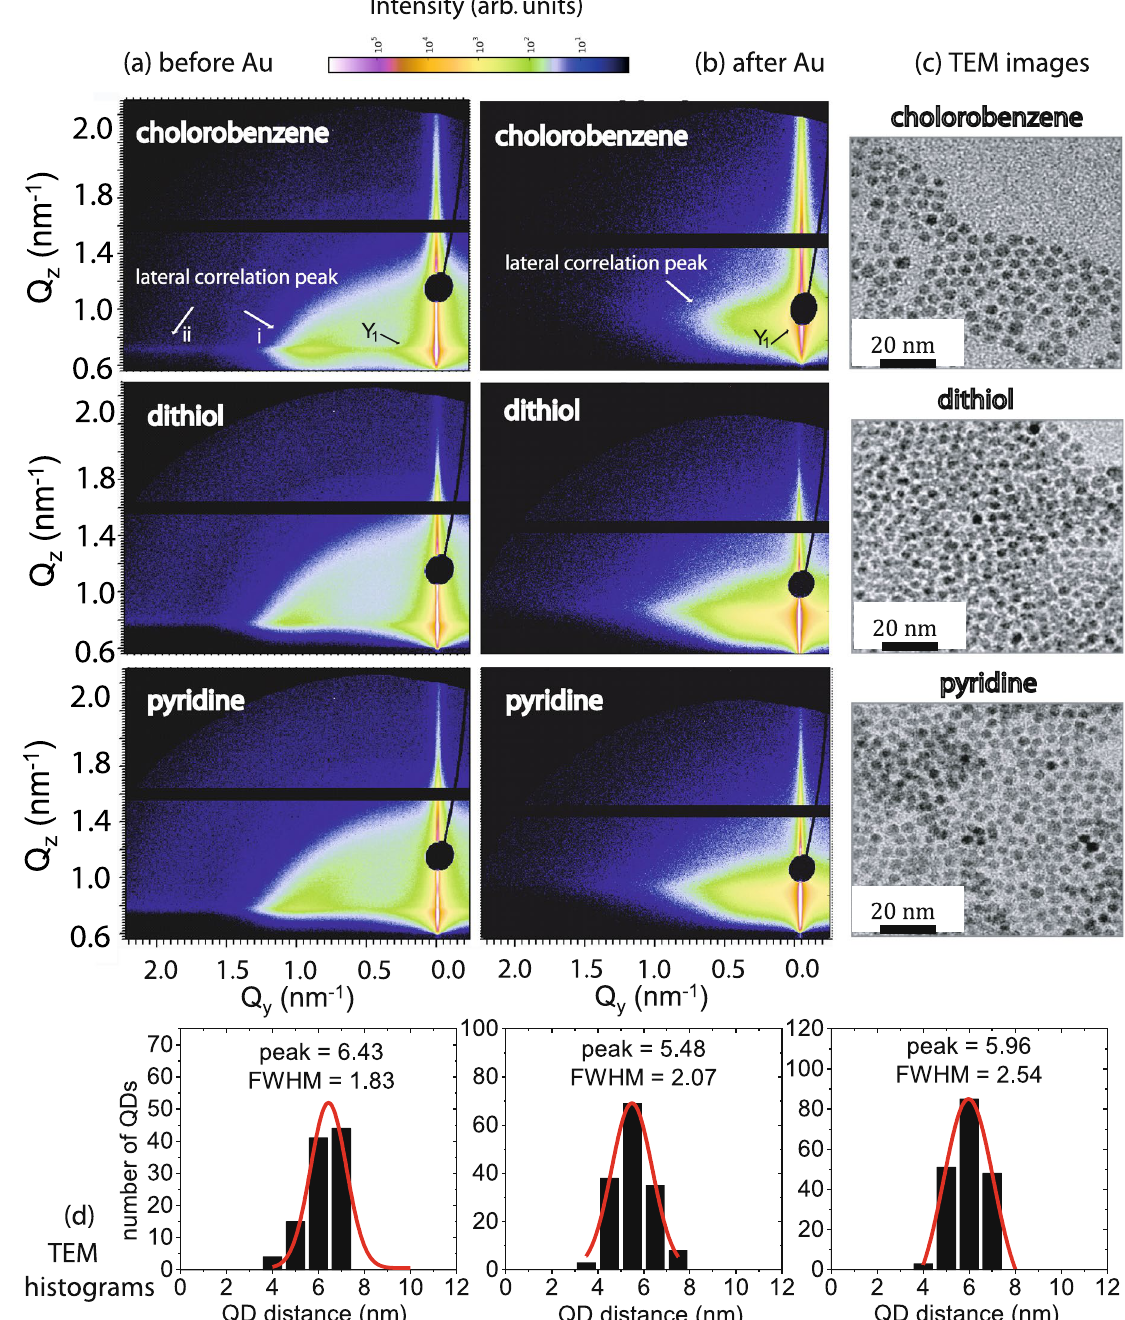
Figure 1. Two-dimensional GISAXS data of the QD array dispersed in three different solvents, namely chlorobenzene , dithiol and pyridine ( a ) before and ( b ) after Au deposition. The circular black shield due to the Pb beam stop is mounted to prevent detector saturation from the intense specular beam. The horizontal black line is the inter-module gap of the detector. ( c ) Corresponding TEM images of the bare QD templates are shown alongside. Reproduced from E. Zillner, PhD thesis , FUB,ISSN 1868-5781, page 55, by courtesy of Zillner 14 . ( d ) Size histograms from analysis of the TEM images. According to the imaging statistics, the mean interparticle distances of 6.4 ± 0.2 nm ( chlorobenzene ), 5.5 ± 0.4 nm ( dithiol ) and 5.9 ± 0.3 nm ( pyridine ) are estimated from the Gaussian fittings of the size distribution